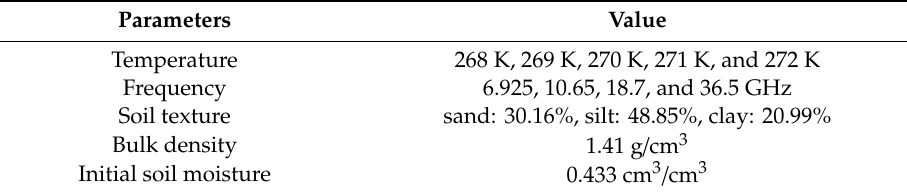
Table 3. Setup of the key parameters in emissivity simulation.